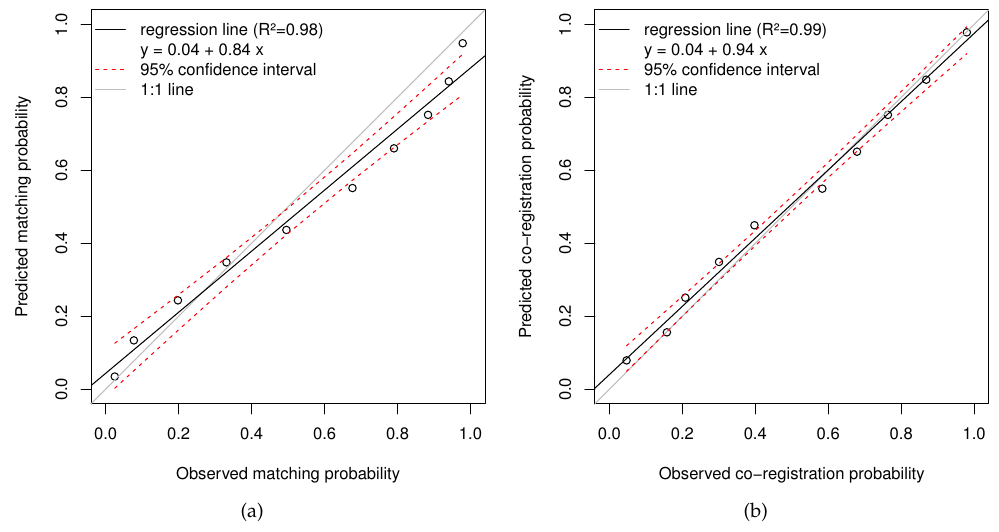
Figure 5. Correlation between predicted probability and observed probability for ( a ) tree matching and ( b )